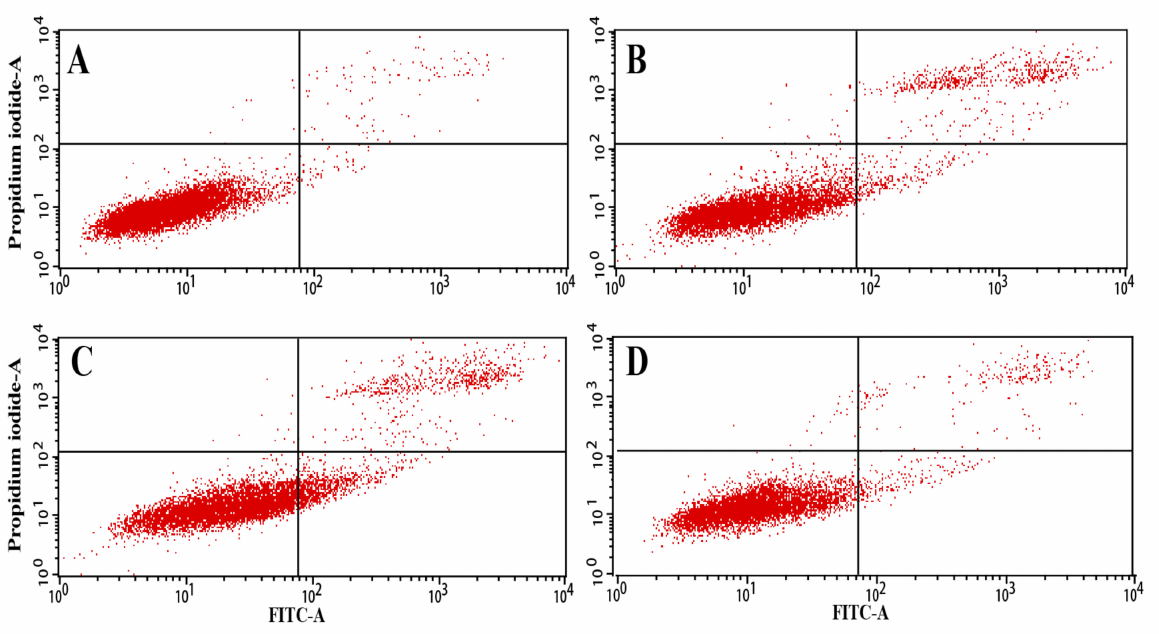
Figure 6. Effect of SPP-0.7A on A549 cell apoptosis, assessed by flow cytometry analysis. Control group ( A ), 25 µ g/mL ( B ), 100 µ g/mL ( C ), and 400 µ g/mL ( D